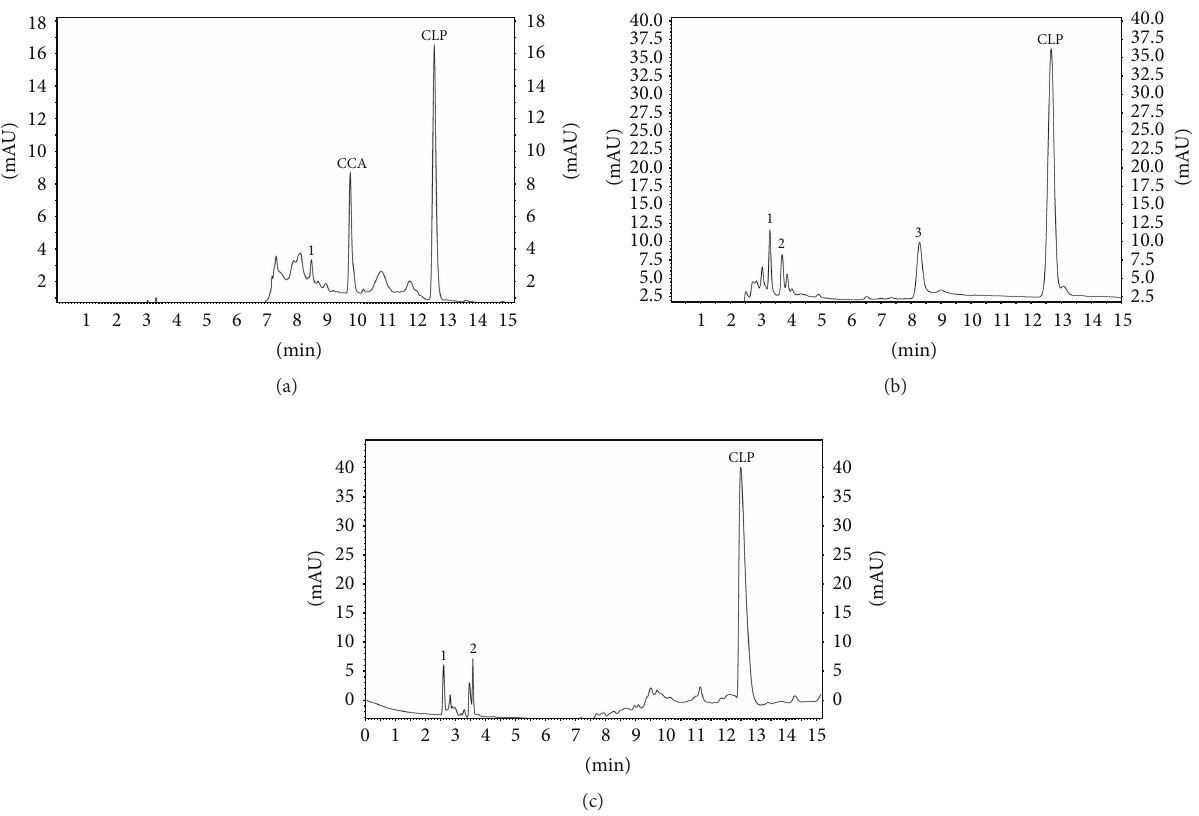
Figure 4: Chromatograms of acid (a), basic (b), and oxidative (c) stress degradation samples of clopidogrel bisulfate (1,2,3-degradation products).